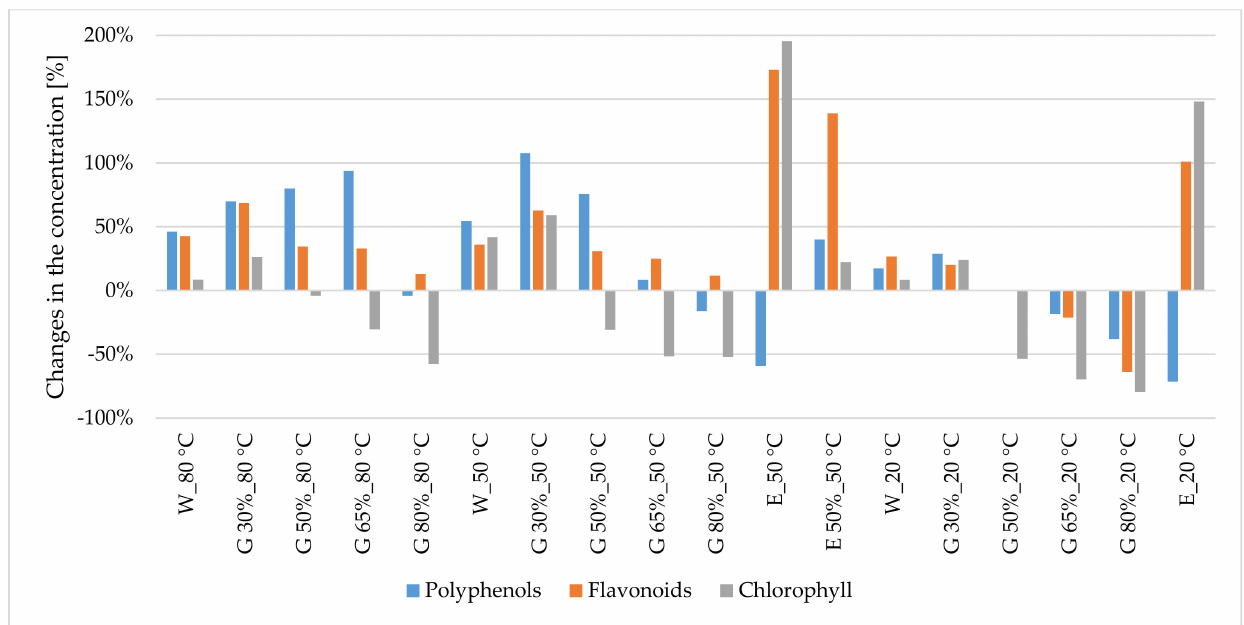
Figure 2. Changes (%) in the concentration of polyphenols, flavonoids and chlorophyll in extracts from common nettle leaves compared with 50% ethanol–water extract (20 ◦ C). W—water, G—glycerol. Sample code—designations as in Table